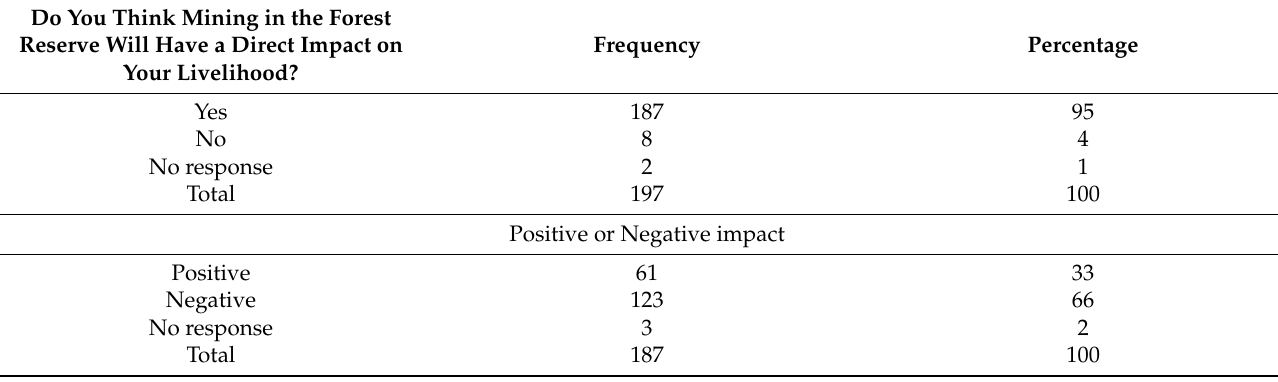
Table 3. Direct impact of mining in the forest reserve on livelihoods of the